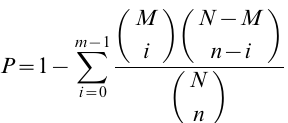
Figure S1 Overview of D. latiflorus flower transcrip- tome sequencing and assembly. A. Length distribution of contigs from phase 1; B. Length distribution of contigs from phase 2; C. Length distribution of scaffolds from phase 1; D. Length distribution of scaffolds from phase 2; E. Length distribution of unigenes from phase 1; F. Length distribution of unigenes from phase 2; G. Length distribution of all unigenes. Figure S2 Plant-specific GO Slim terms for the D. latiflorus florally expressed unigenes. The bar chart provides the plant-specific GO slim terms enriched for unigenes expressed in D. latiflorus flowers. Figure S3 KEGG pathway categories assigned with D. latiflorus flower unigenes. A. Top KEGG pathways highly represented by D. latiflorus flower unigenes. B. KEGG metabolism pathways. C. KEGG secondary metabolism pathways. Figure S4 Pathways regulating the floral transition in Arabidopsis, rice and temperate grasses (Compiled